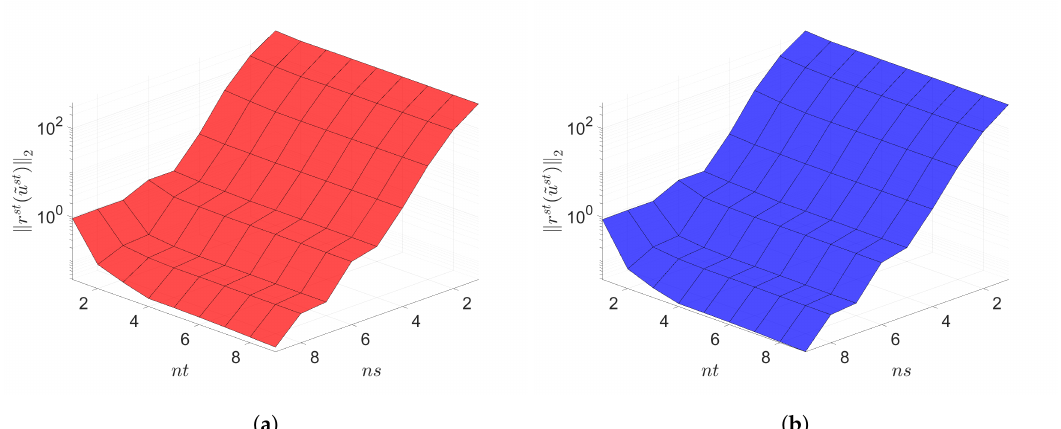
Figure 13. 2D linear convection diffusion equation. Space-time residuals vs. reduced dimensions. Note that the scales of the z -axis, i.e., the residual norm, are the same both for Galerkin and LSPG. Although the LSPG achieves slightly lower minimum residual norm values than the Galerkin, both Galerkin and LSPG show comparable results. ( a ): Space-time residuals vs. reduced dimensions for Galerkin projection, ( b ): Space-time residuals vs. reduced dimensions for LSPG projection.